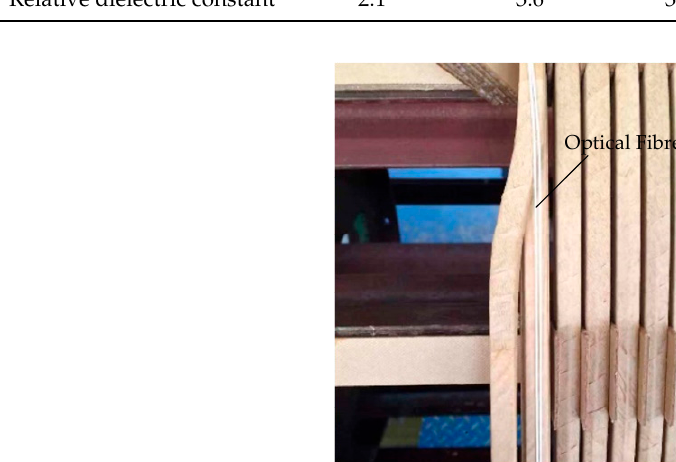
Figure 4. ( a ) Electrical field distribution of original conductor; ( b ) electrical field distribution of optical fibre composite conductor and ( c ) electrical field distribution in the optical fibre.